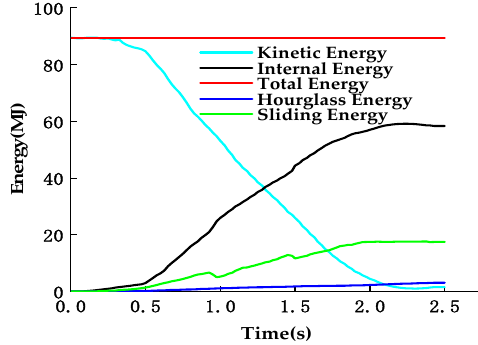
Figure 15. Energy diagram of aluminum alloy supporting.